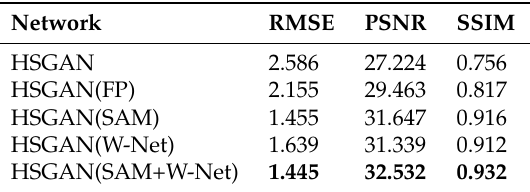
Table 4. Detailed analysis of the proposed SAPWNet with different settings. HSGAN, hyperspectral reconstruction GAN with U-Net generator; FP, feature pyramid without scale attention; SAM, scale attention module; W-Net, using W-Net replacing the